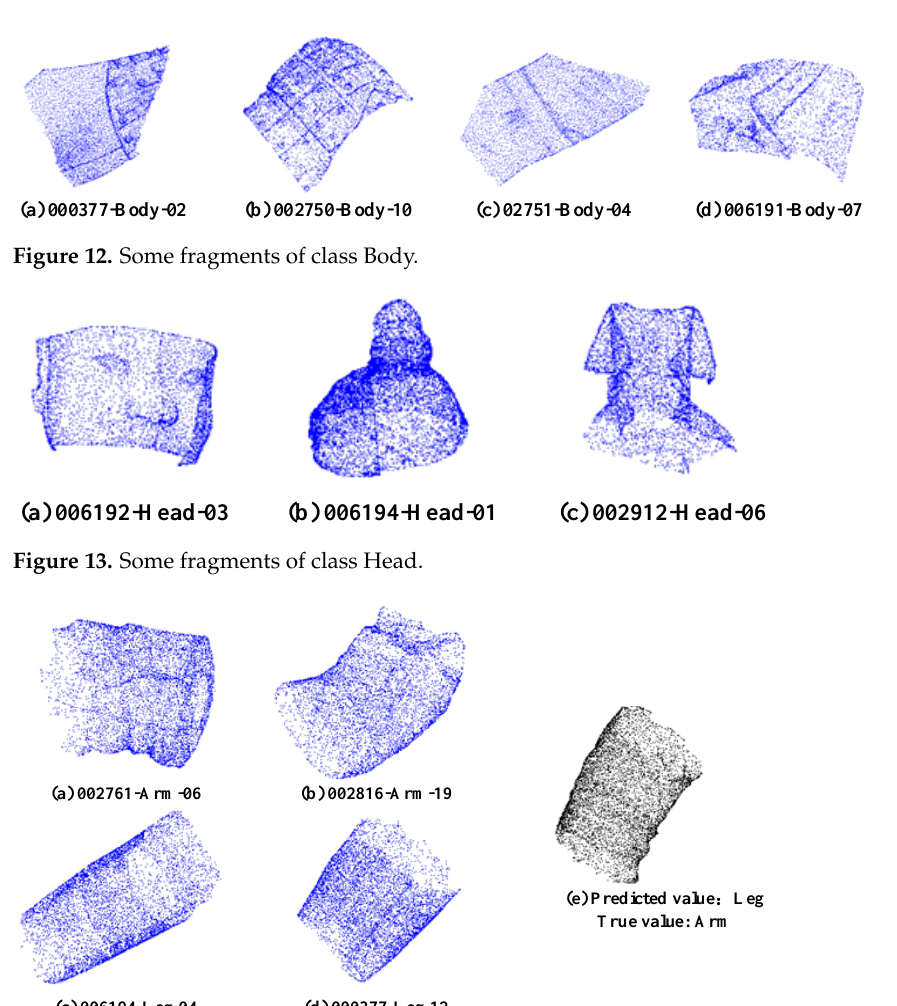
Figure 14. Some fragments of class Arm ( a , b ) and Leg ( c , d ). ( e ) Misclassification result.